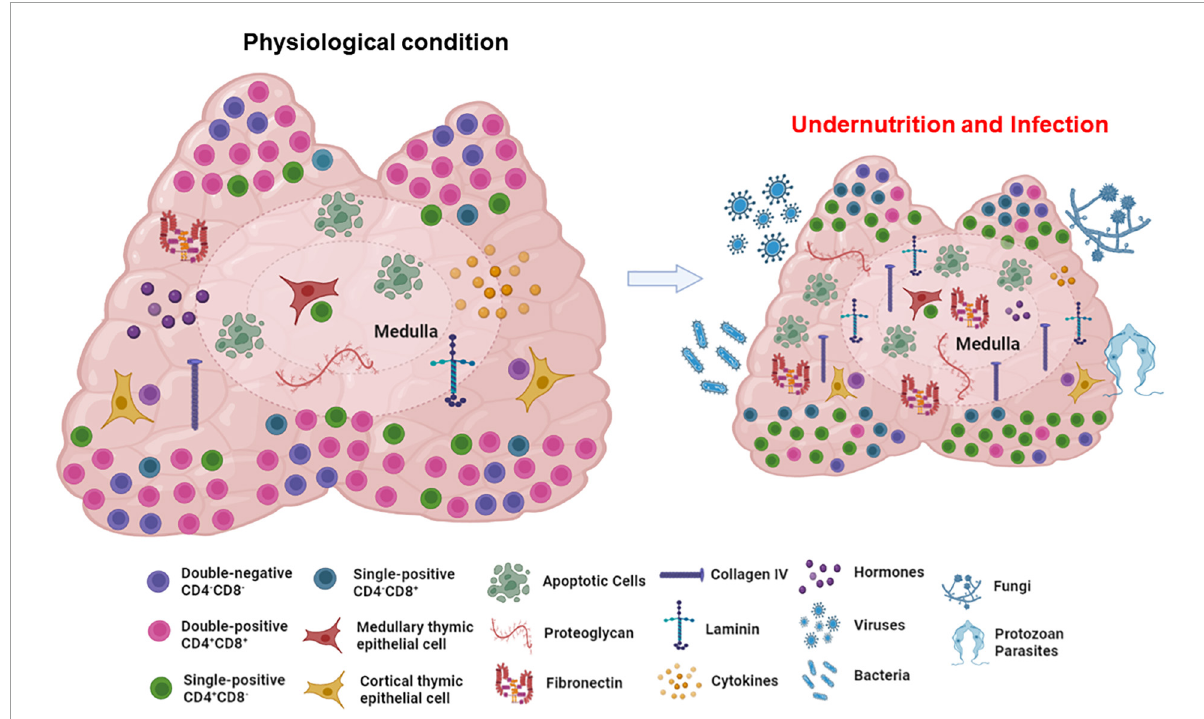
FIGURE6 Effects of undernutrition upon the thymic lymphoid and microenvironmental compartments. The scheme clearly shows the atrophy of the thymus in undernutrition conditions, affecting both developing thymocytes and microenvironmental elements of the organ. Importantly, undernourished thymuses are more susceptible to infections and thymic changes are still more pronounced. Figure created with